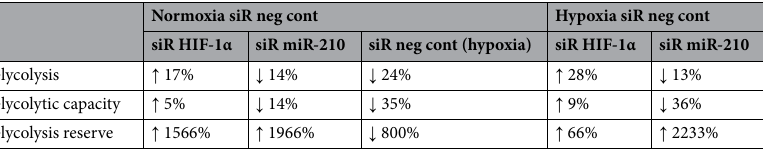
Table 3. Comparison of the ECAR values to siR neg cont in normoxia for siR HIF-1α and siR miR-210. Comparison of the ECAR values to siR neg cont in hypoxia for siR HIF-1α and siR miR-210 in hypoxia.